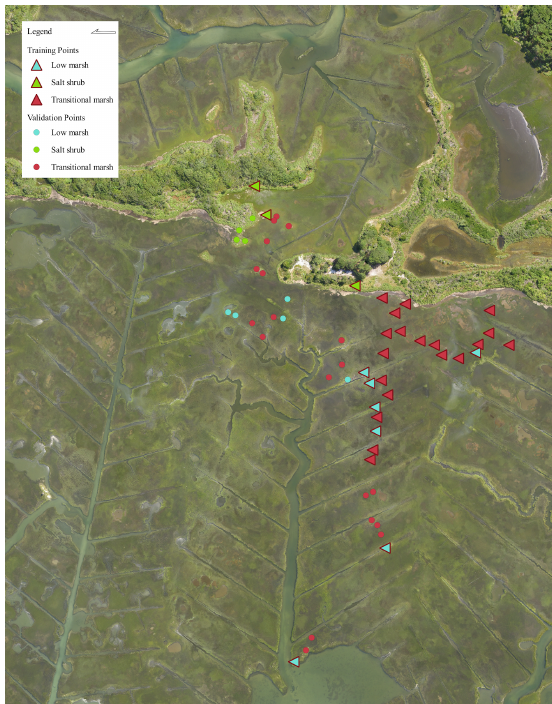
Figure 7. Marsh Type Training and Validation Points